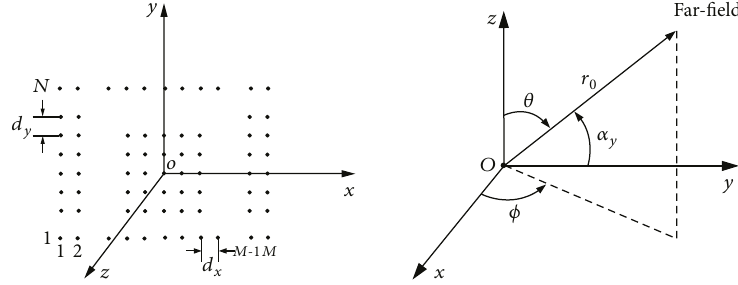
Figure 3: Spatial relation of the AESA antenna.